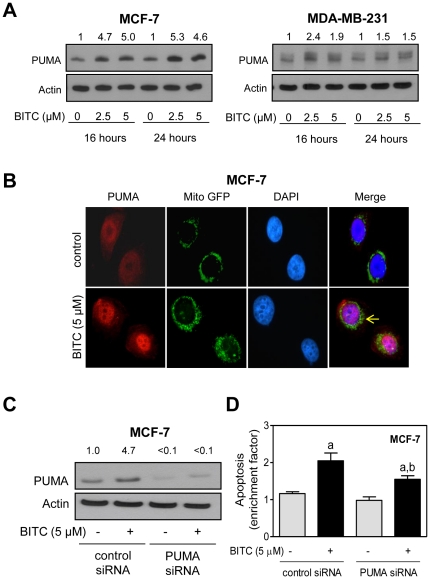
BITC treatment increases PUMA protein level in MCF-7 and MDA-MB-231 cells.(A) Western blotting for PUMA using lysates from MCF-7 and MDA-MB-231 cells treated with DMSO (control) or BITC (2.5 or 5 µM) for the indicated time periods. Number above band indicates change in level compared to corresponding DMSO-treated control. (B) Immunofluorescence microscopy for PUMA in Mito GFP expressing MCF-7 cells after 24 h treatment with DMSO or 5 µM BITC (100× objective magnification). Arrow represents localization of PUMA in mitochondrion. (C) Immunoblotting for PUMA using lysates from MCF-7 cells transiently transfected with a control siRNA or PUMA-targeted siRNA and treated for 24 h with DMSO or 5 µM BITC. (D) Quantitation of histone-associated DNA fragment release into the cytosol (a measure of apoptosis) in MCF-7 cells transiently transfected with a control siRNA or PUMA-targeted siRNA and treated for 24 h with DMSO or 5 µM BITC. Results are expressed as enrichment relative to corresponding DMSO-treated control. Data represent mean ± SD (n = 2–3). Significantly different (P<0.05) compared with arespective DMSO-treated control and bbetween control siRNA transfected and PUMA siRNA transfected cells by one-way ANOVA followed by Bonferroni's multiple comparison test. The experiments were repeated twice and data from one representative experiment are shown.